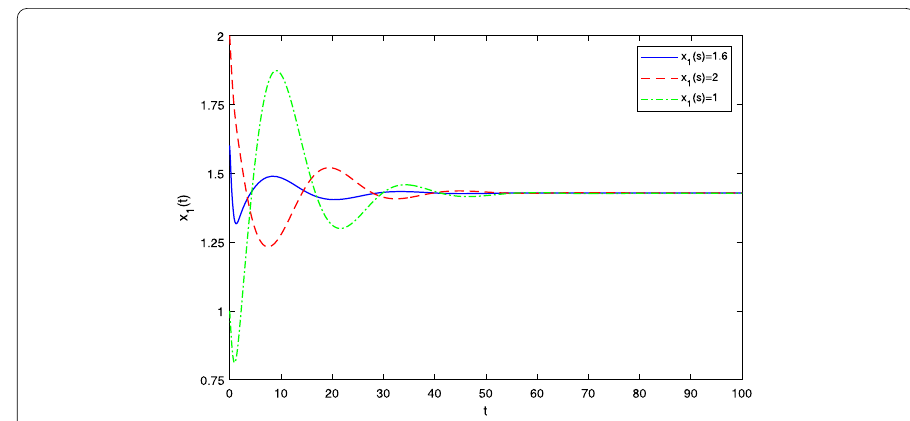
Figure 4 Time responses of state variable x 1 ( t ) with α = 0.75